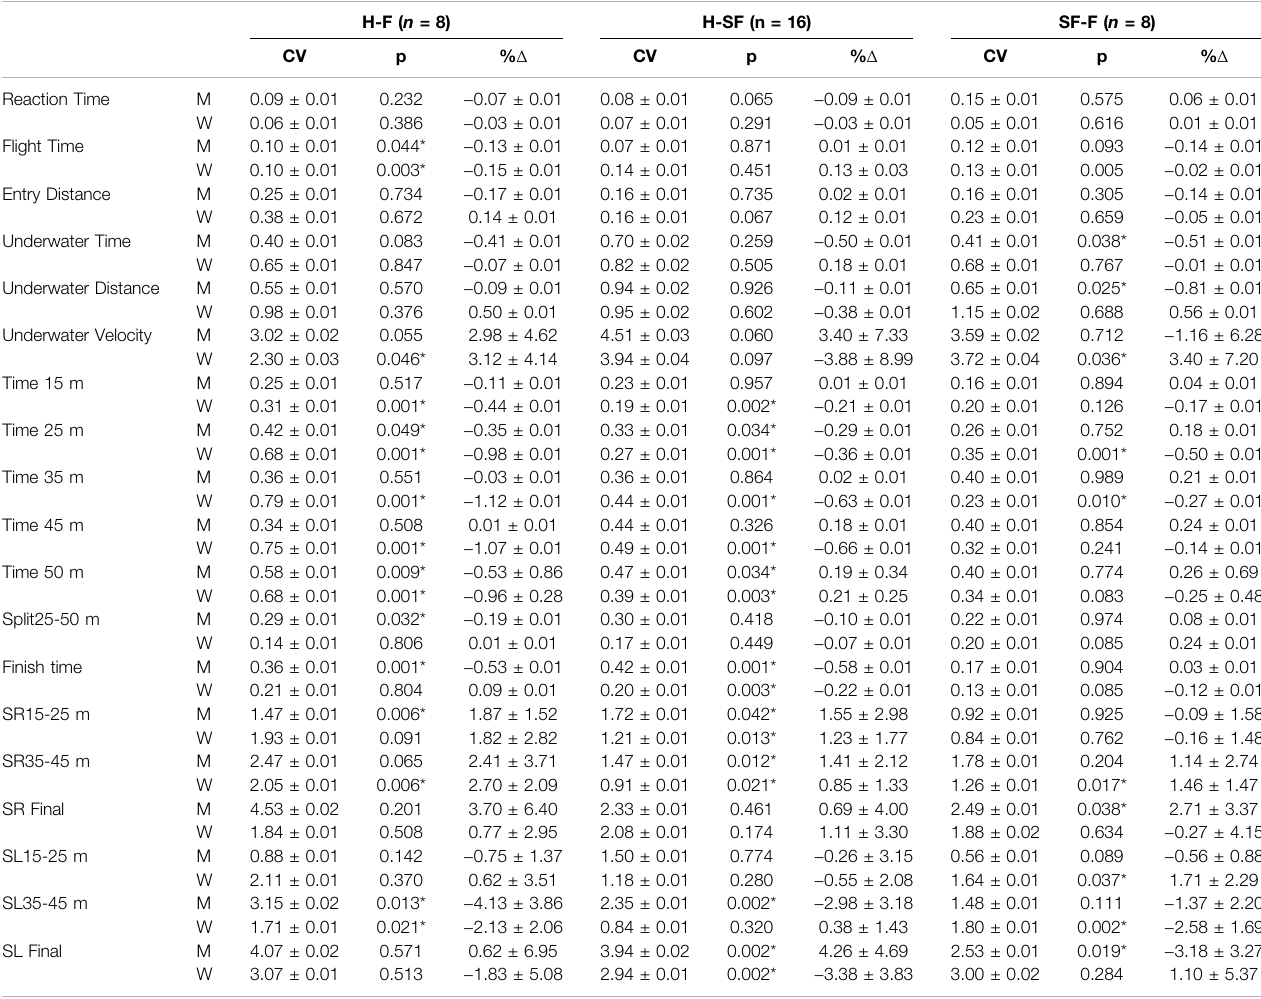
TABLE 5 | Freestyle intra-athletes ’ coef fi cient of variation (CV) and relative change in performance (% Δ ). Men (M); Women (W); Heat (H); Semi- fi nal (SF); Final (F) (LEN European Senior Championships 2021). H-F ( n =